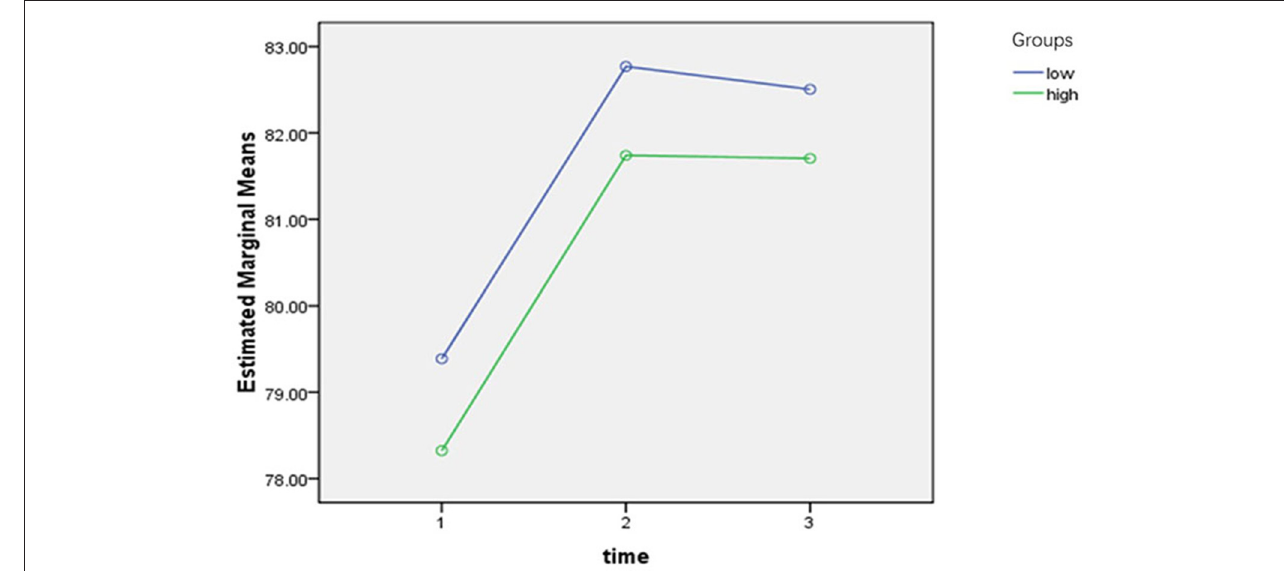
FIGURE 3 | Angle A and repeated measures analysis of variance at three postoperative time points.